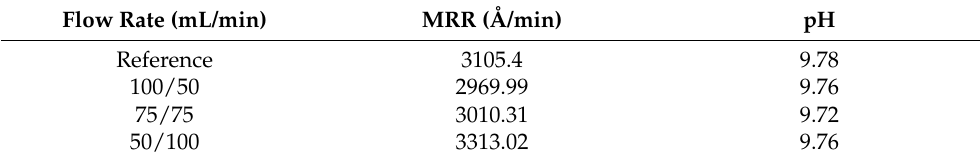
Table 1. MRR and pH of reference and the two-way injection with position; slurry–H 2 O 2 .